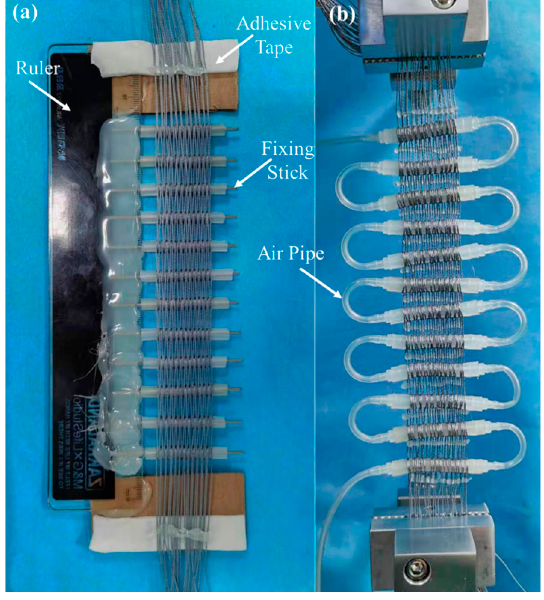
Figure 5. ( a ) Manufacturing board of HPAM ( b ) picture of HPAM fixed on the clamp of the test bench.